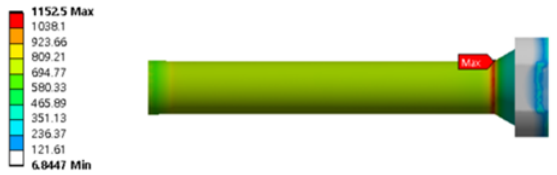
Figure 6. Von-mises stress of stem.